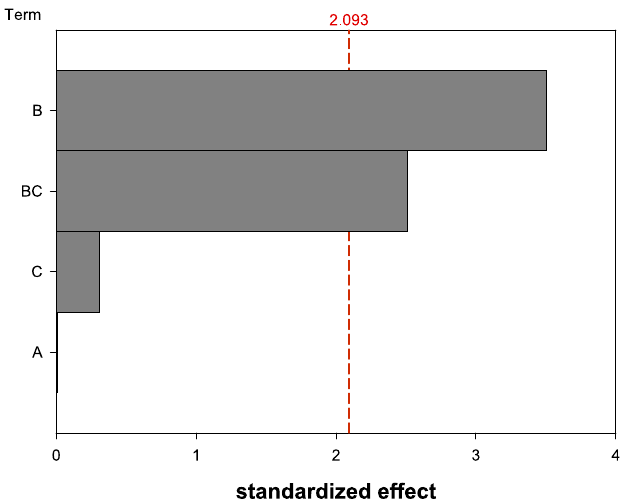
Figure 3. Pareto diagram of standardized effect regarding the HD change before and after lyophilization for the parameters (A) shelf temperature for primary drying, (B) trehalose content, and (C) volume of nanocapsule suspension (software: Minitab ® 19). Answer is calculated HD quotient before and after lyophilization; α = 0.05.